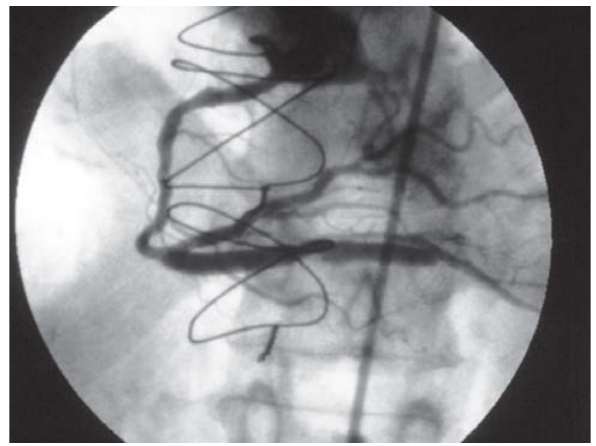
Fig. 1 - Enxerto coronário-coronário pérvio após quatro anos de